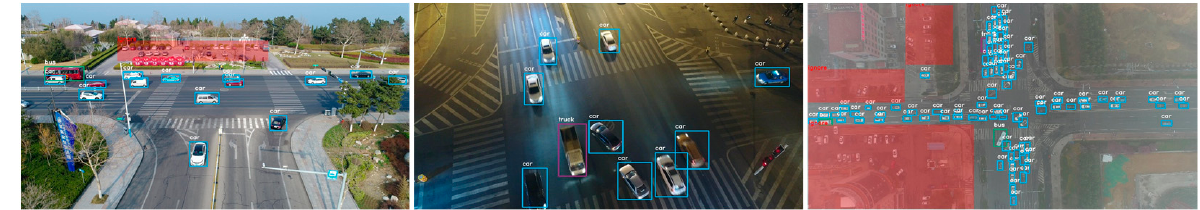
Figure 2. Annotated example images from the UAVDT dataset [41] showing some of the variations included. The areas marked in red were not annotated and are therefore not considered in the eval- uation.